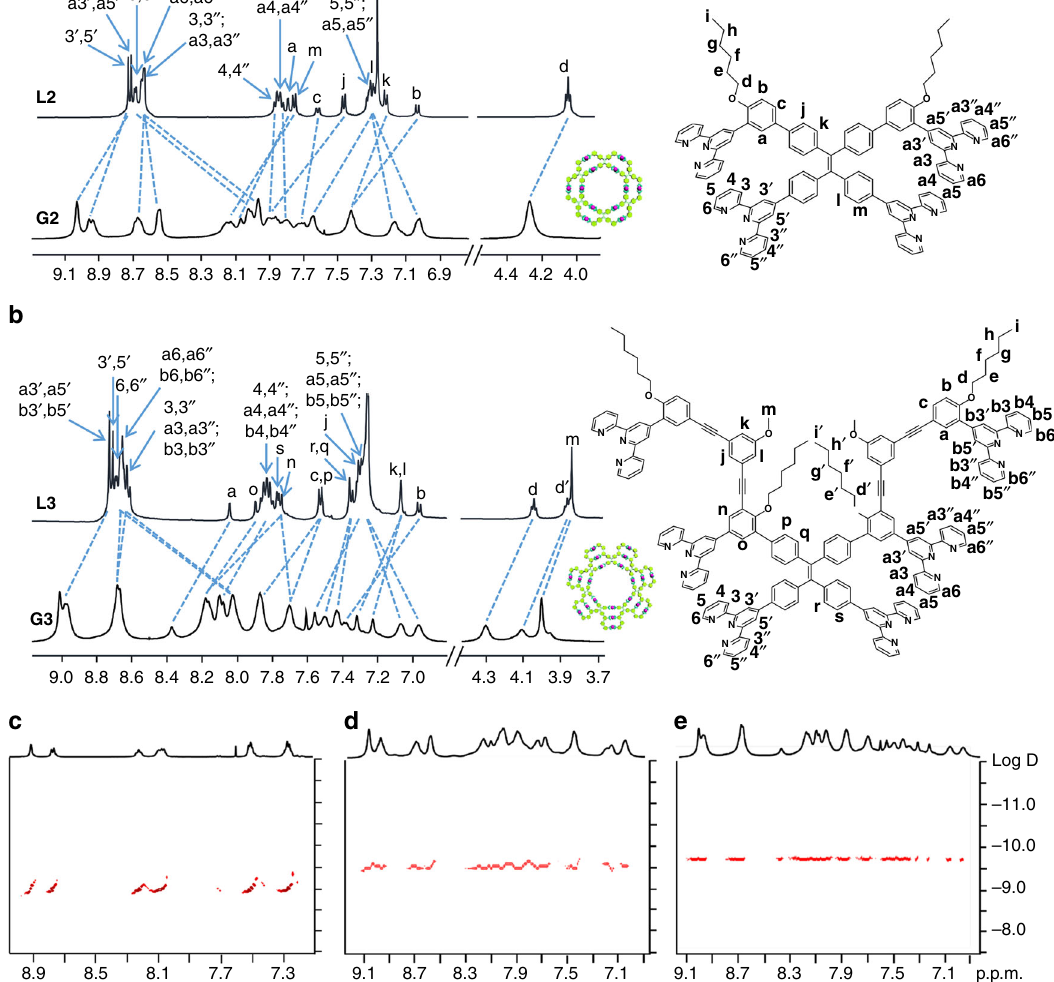
Fig. 2 1 H-NMR spectra. a L2 and G2 ; b L3 and G3 ; c DOSY of G1 ; d DOSY of G2 ; e DOSY of G3 (500 MHz, 300 K, CDCl 3 for ligands and CD 3 CN